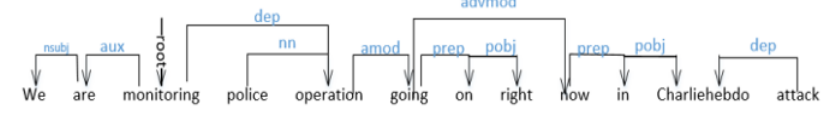
Fig. 1. Syntactic dependency